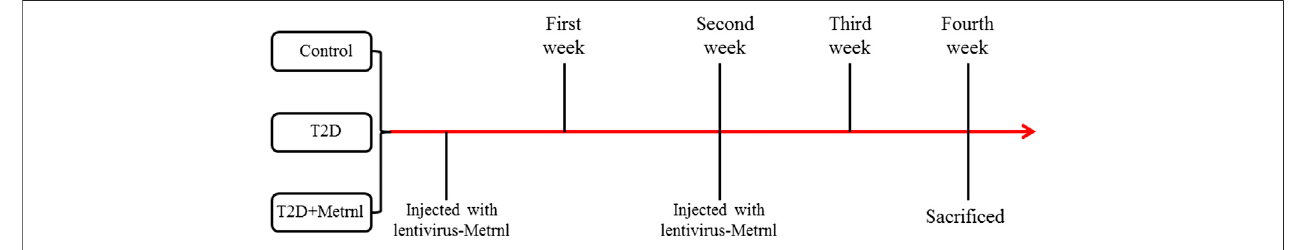
FIGURE 1 | Time axis indicating mice